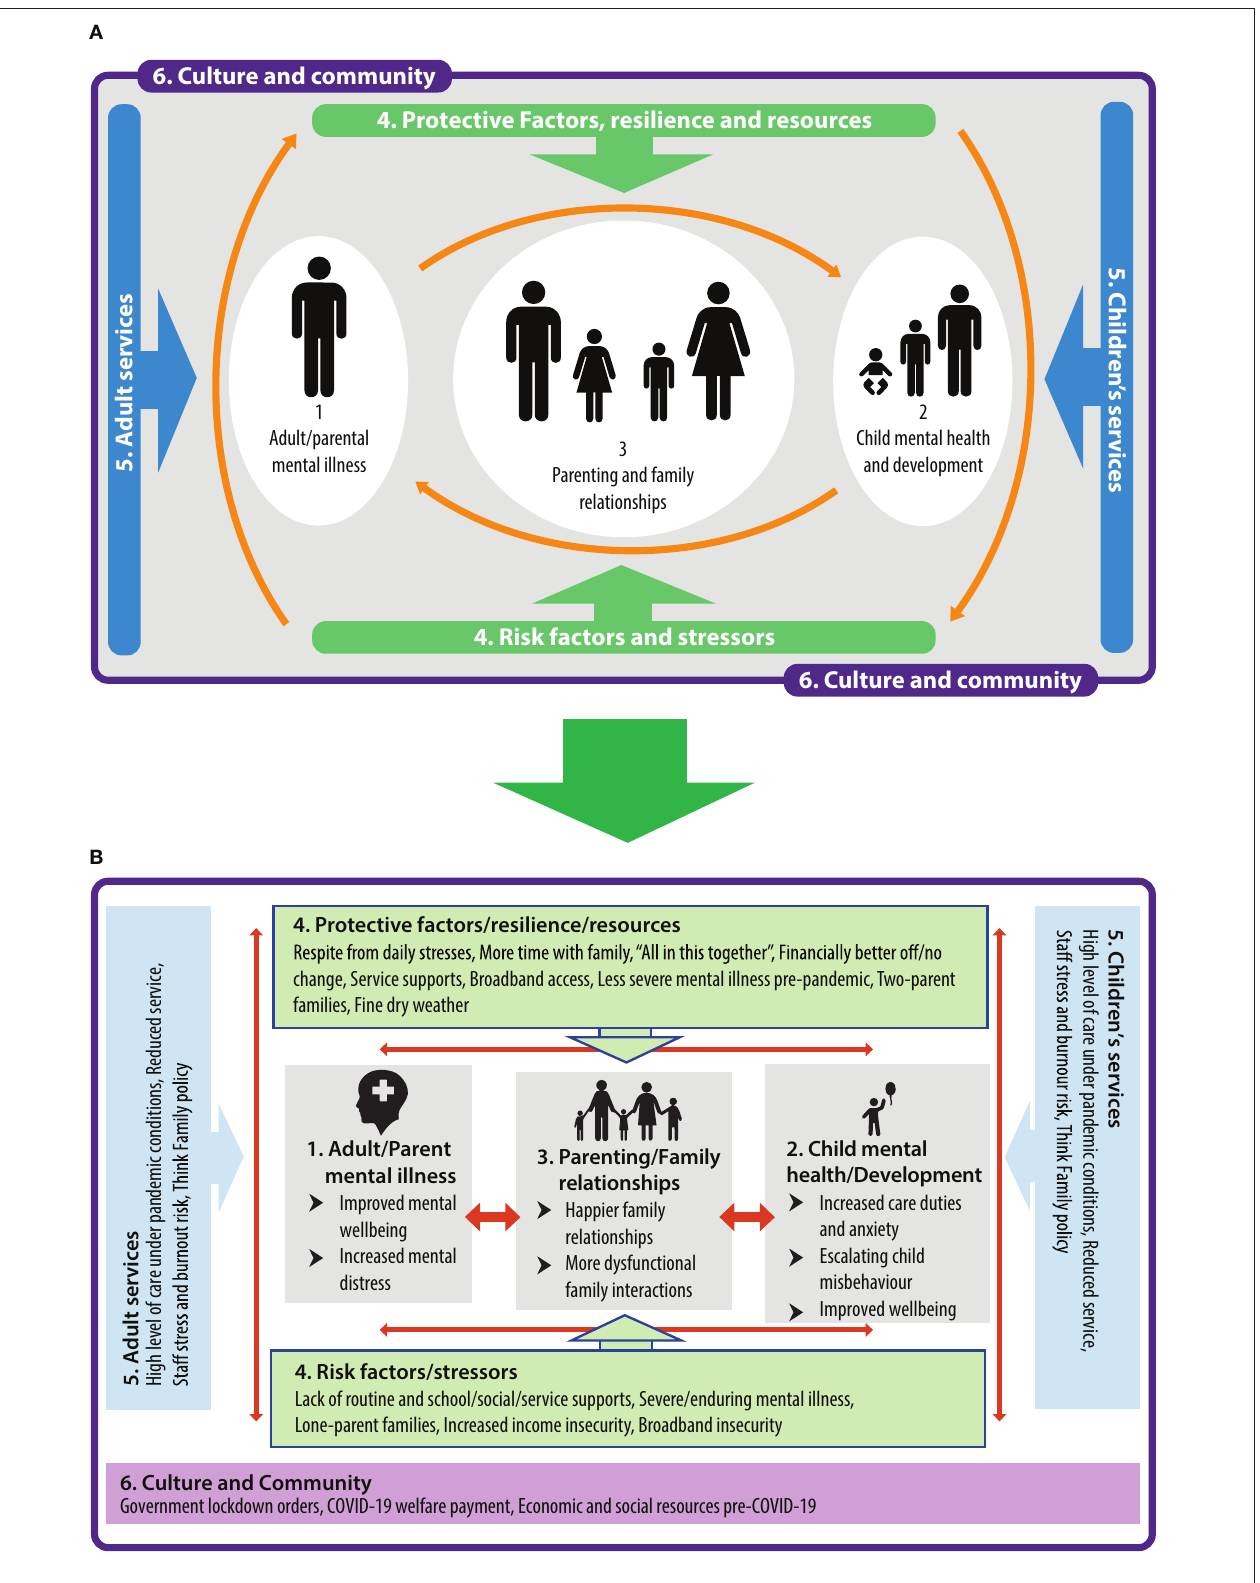
FIGURE 1 | (A) The family model (16). (B) Qualitative themes contextualised within framework of the family model.